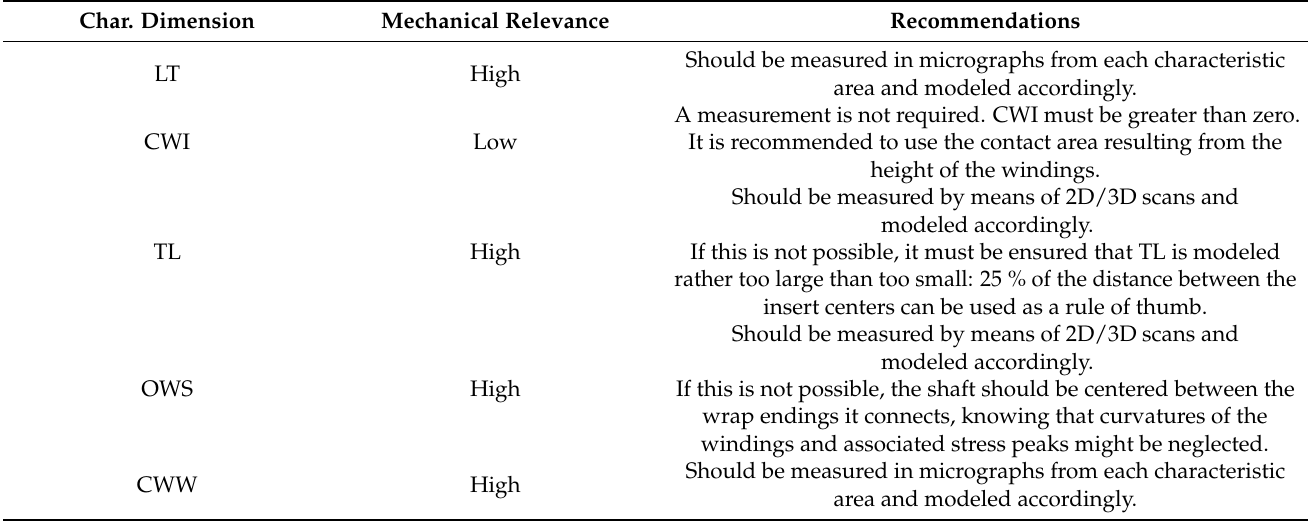
Table 5. Recommendations for the determination and modeling of characteristic